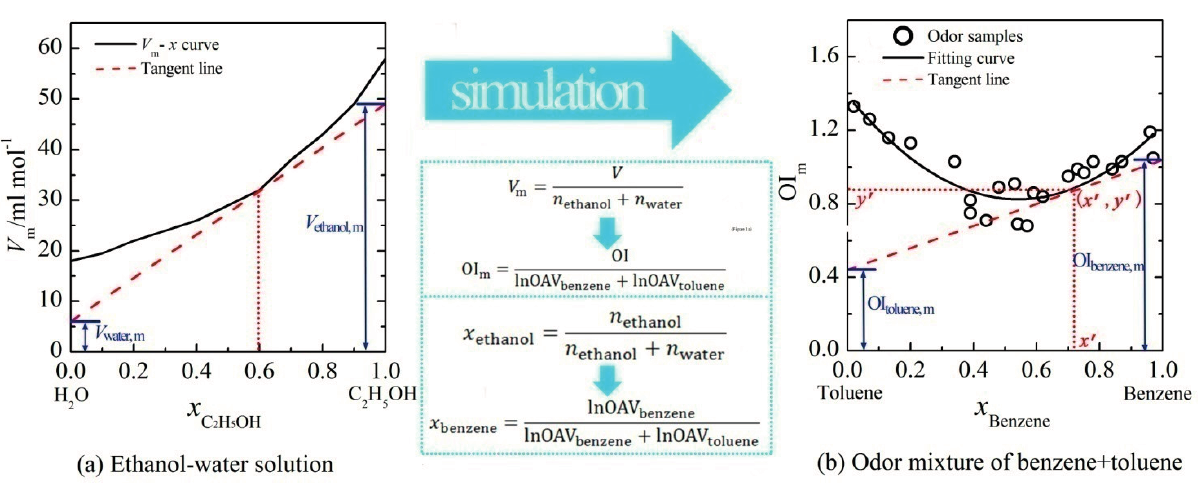
Figure 1. The ( a ) tangent-intercept method of partial molar volume; and ( b ) the methodology of PDE model for binary odor mixture by reference to it